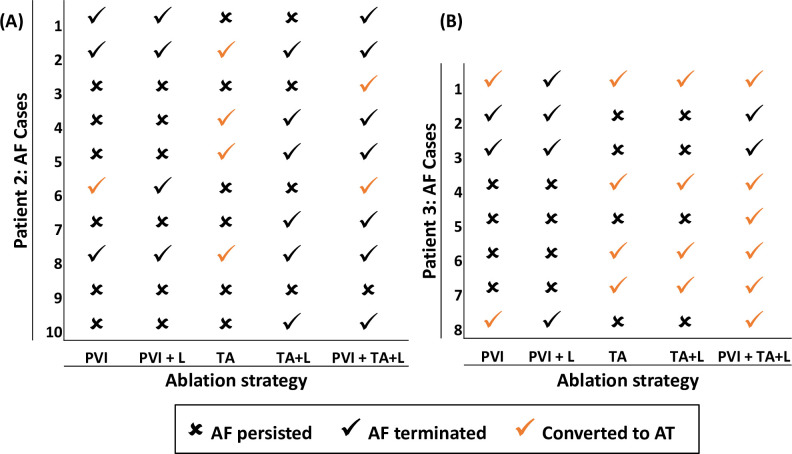
Comparison of the fibrosis burden to TA volume of in each patient-specific LA models.A: distribution of TAs across different regions of the atrial wall; dense fibrotic region (black), border zone (BZ—dark grey) and healthy tissue (light grey). The majority of TAs lie in the fibrotic region in Patients 1, 2 and 3 (FB > 25%, Utah 4 and 3), compared to much lower numbers in Patients from 4, 5 and 6 (FB < 25%, Utah 3 and 4). B: bar chart with FB (blue) and volume of all identified TAs (orange) in each model. The difference between FB and TA volume decreases with the decrease in Utah score, showing that the predicted TAs can be most efficient in improving CA in Utah 3 and 4 patients.